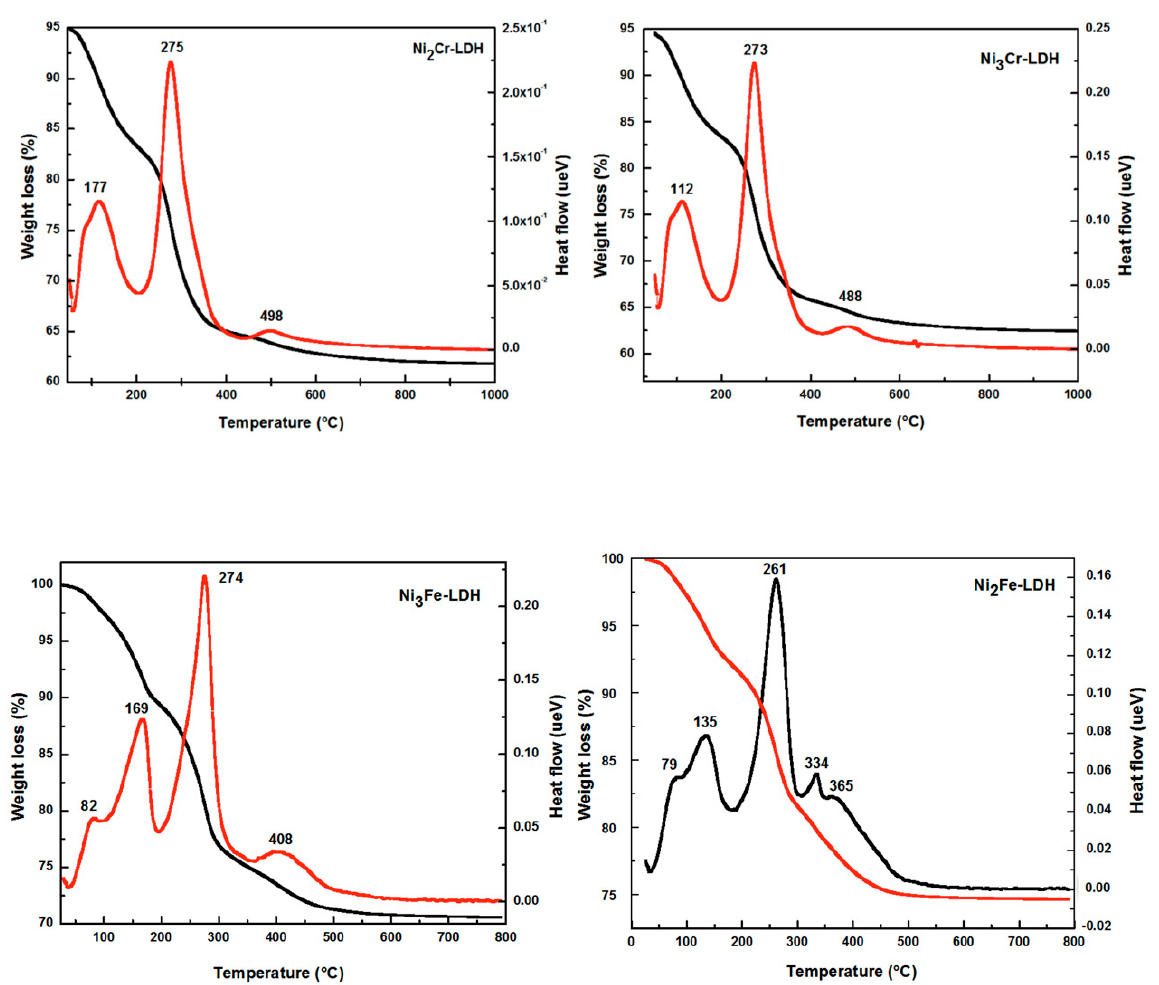
Figure 4. TG-DTA curves of Ni R Cr and Ni R Fe LDH precursors.